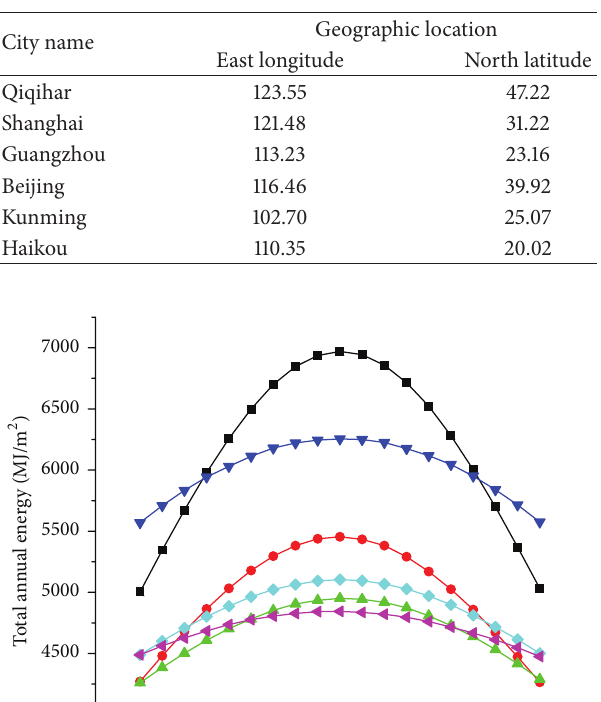
Table 1: Geographic location of six cities in China.